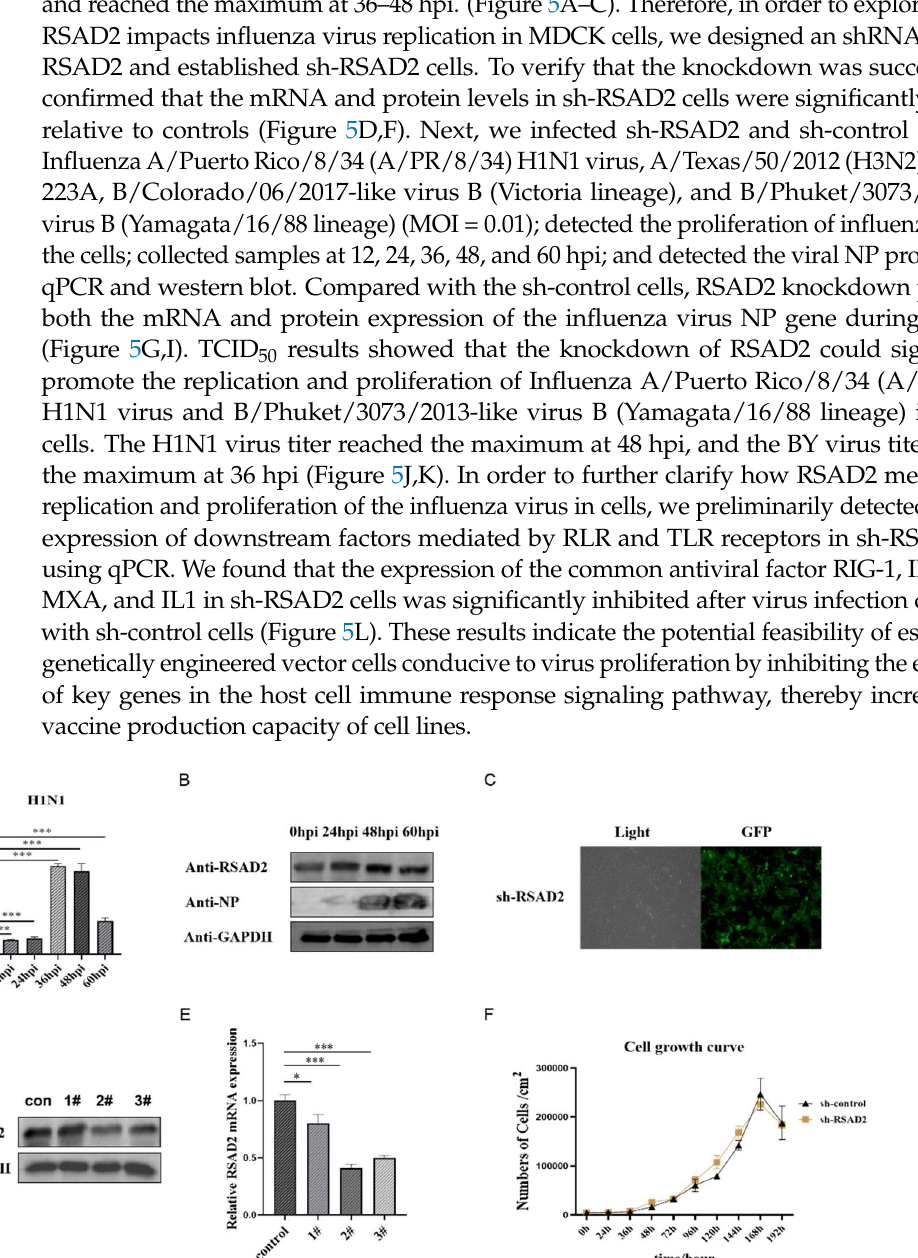
Figure 5 . Knockdown of RSAD2 promotes influenza virus proliferation. ( A ) RSAD2 gene expression was detected in MDCK cells infected with IAV H1N1 at 0, 12, 24, 36, 48, and 60 h post infection (hpi) using qPCR. ( B ) RSAD2 protein expression was detected in MDCK cells infected with IAV H1N1 at 0, 24, 48, and 60 hpi using western blot. ( C ) Representative images of sh-RSAD2 with a GFP tag using a 40× fluorescence microscope are shown. ( D ) Protein expression of RSAD2 in sh-RSAD2 MDCK cells was measured using western blot to verify successful knockdown. ( E ) Gene expression of RSAD2 in sh-RSAD2 (#1, #2, #3) MDCK cells was measured using qPCR to verify successful knockdown. ( F ) The proliferation of sh-control and sh-RSAD2 cells was detected using the digestion technique. ( G ) Influenza A/Puerto Rico/8/34 (A/PR/8/34) H1N1 virus, A/Texas/50/2012 (H3N2) NYMCX-223A, B/Colorado/06/2017-like virus B (Victoria lineage), and B/Phuket/3073/2013-like vi- rus B (Yamagata/16/88 lineage) NP gene expression were measured in sh-RSAD2 MDCK cells using qPCR. ( H,I ) Influenza A/Puerto Rico/8/34 (A/PR/8/34) H1N1 virus, A/Texas/50/2012 (H3N2) NYMCX-223A, B/Colorado/06/2017-like virus B (Victoria lineage), and B/Phuket/3073/2013-like vi- rus B (Yamagata/16/88 lineage) NP protein expression were measured in sh-RSAD2 MDCK cells using western blot. ( J , K ) Growth kinetics of the influenza A/Puerto Rico/8/34 (A/PR/8/34) H1N1 virus, A/Texas/50/2012 (H3N2) NYMCX-223A, B/Colorado/06/2017-like virus B (Victoria lineage), and B/Phuket/3073/2013-like virus B (Yamagata/16/88 lineage) vaccine strain by TCID 50 method. ( L ) Antiviral factor gene expression was measured in sh-RSAD2 MDCK cells using qPCR. GAPDH was used as the reference gene for qPCR and GAPDH was used as the loading control for western blot. * Was used to determine statistically significant differences between groups; * p < 0.05, ** p < 0.01, *** p < 0.001).